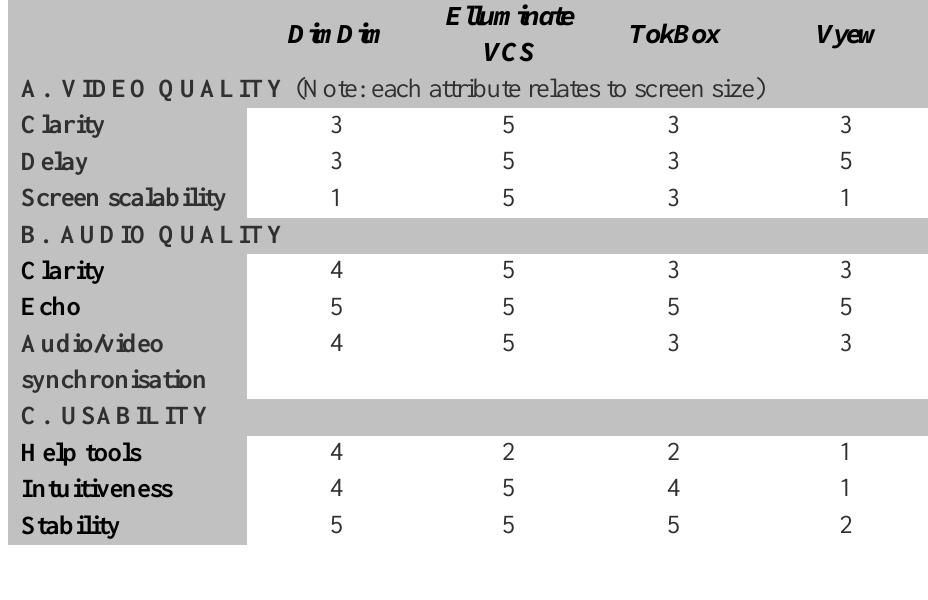
Ratings of Product Audio/Video Quality (1 – negative; 5 =